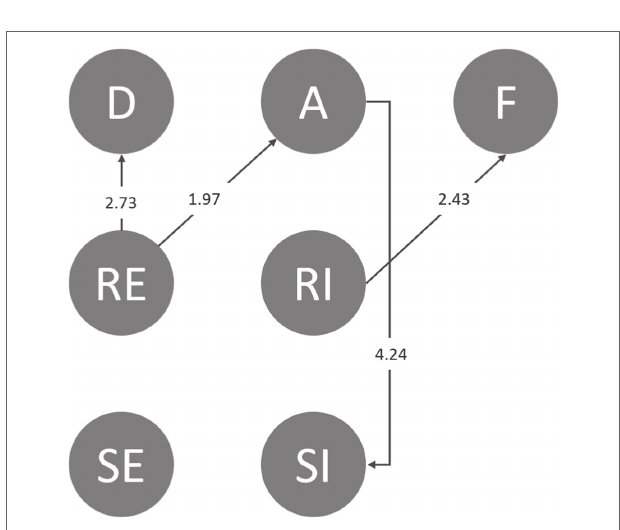
FIGURE 10 | Behavioral transition diagram of the two sets of